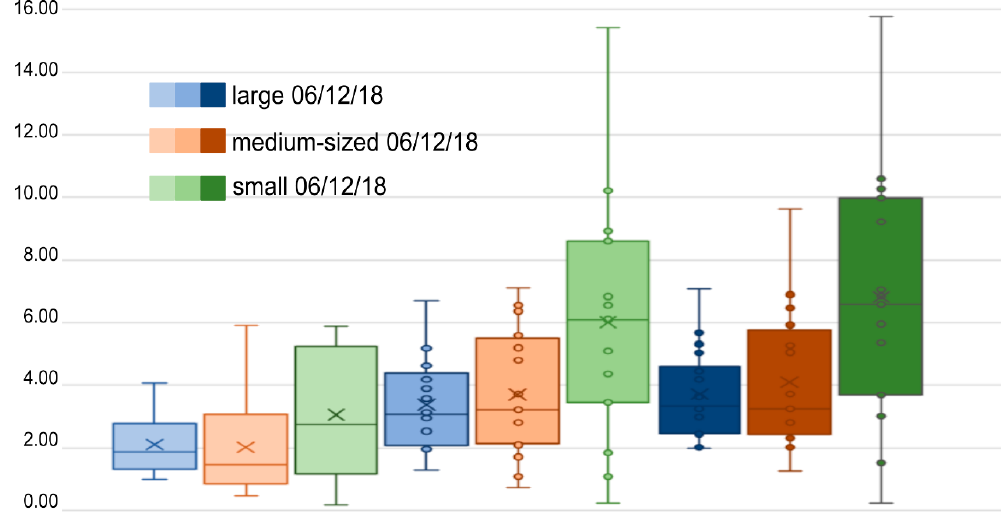
Figure 8. The value of the OU index in demographic classes in 2006, 2012, and 2018.